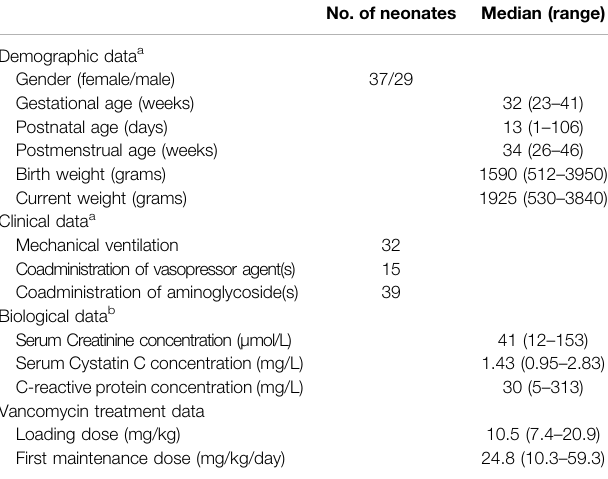
TABLE 1 | Baseline characteristics of the 66